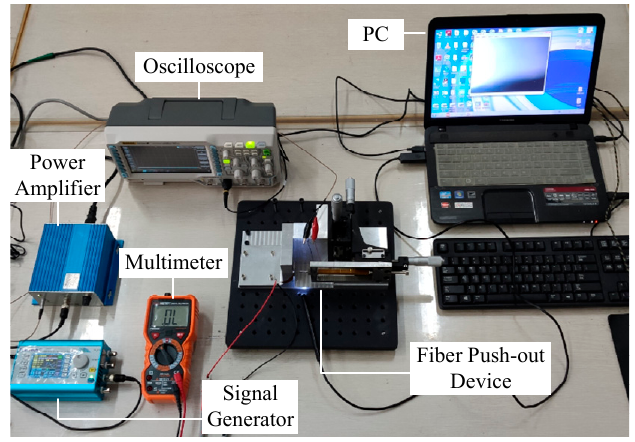
Figure 13. Experiment environment.